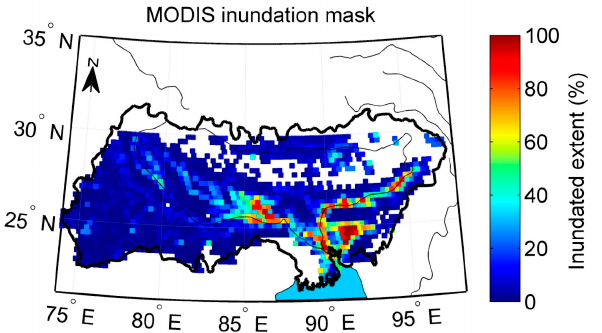
Figure 3. MODerate-resolution Imaging Spectroradiometer (MODIS)-derived surface water extent (MODIS inundation extent mask in the followings) over the GB system given in percentage of the pixel area.